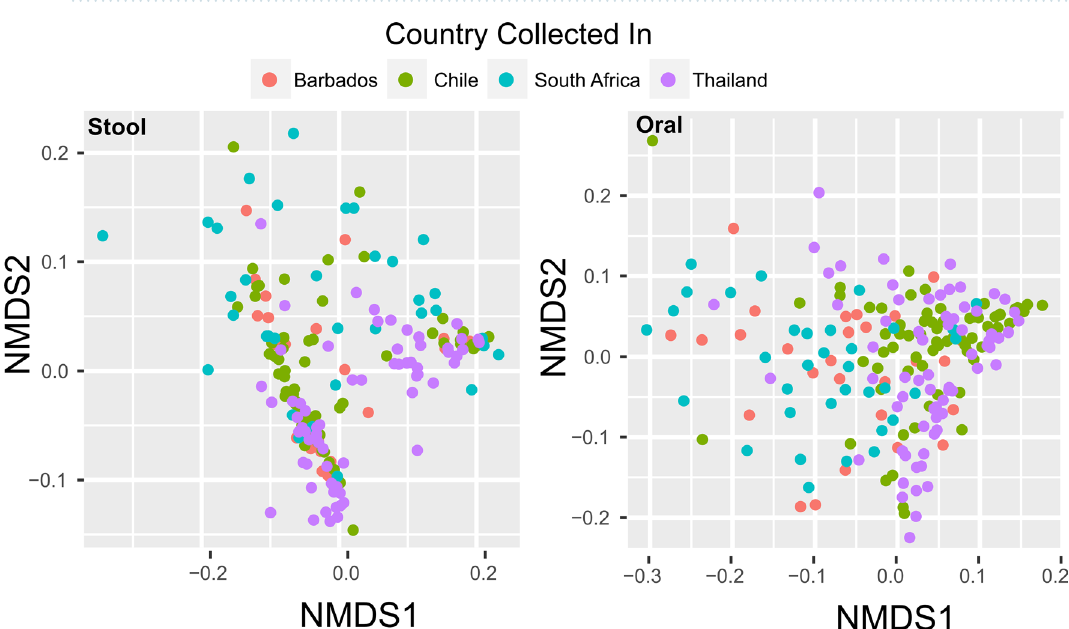
Figure 5. Oral ( n = 195) and stool ( n = 196) microbiota differences according to body site and geographical location (Barbados, Chile, Thailand and S. Africa). Measured by NMDS using weighted UniFrac distance in stool (PERMANOVA r 2 = 0.084, p = 0.001), and oral (PERMANOVA r 2 = 0.161, p =